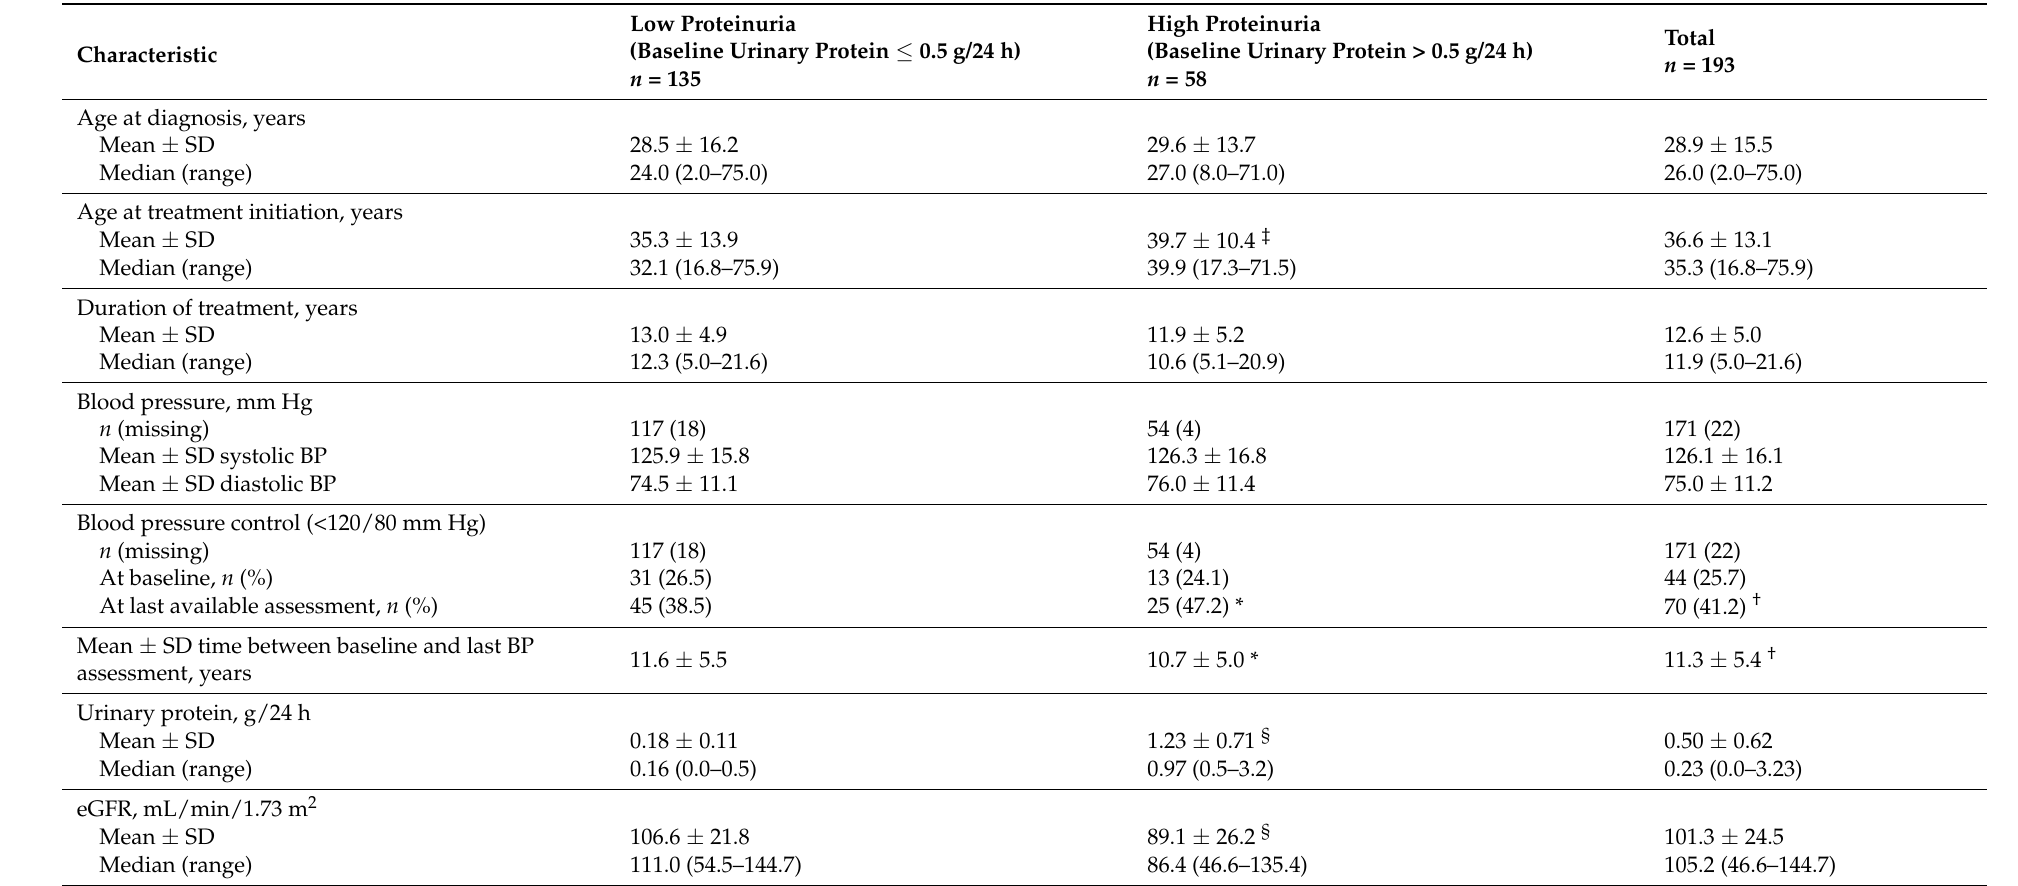
Table 1. Patient characteristics by level of proteinuria at